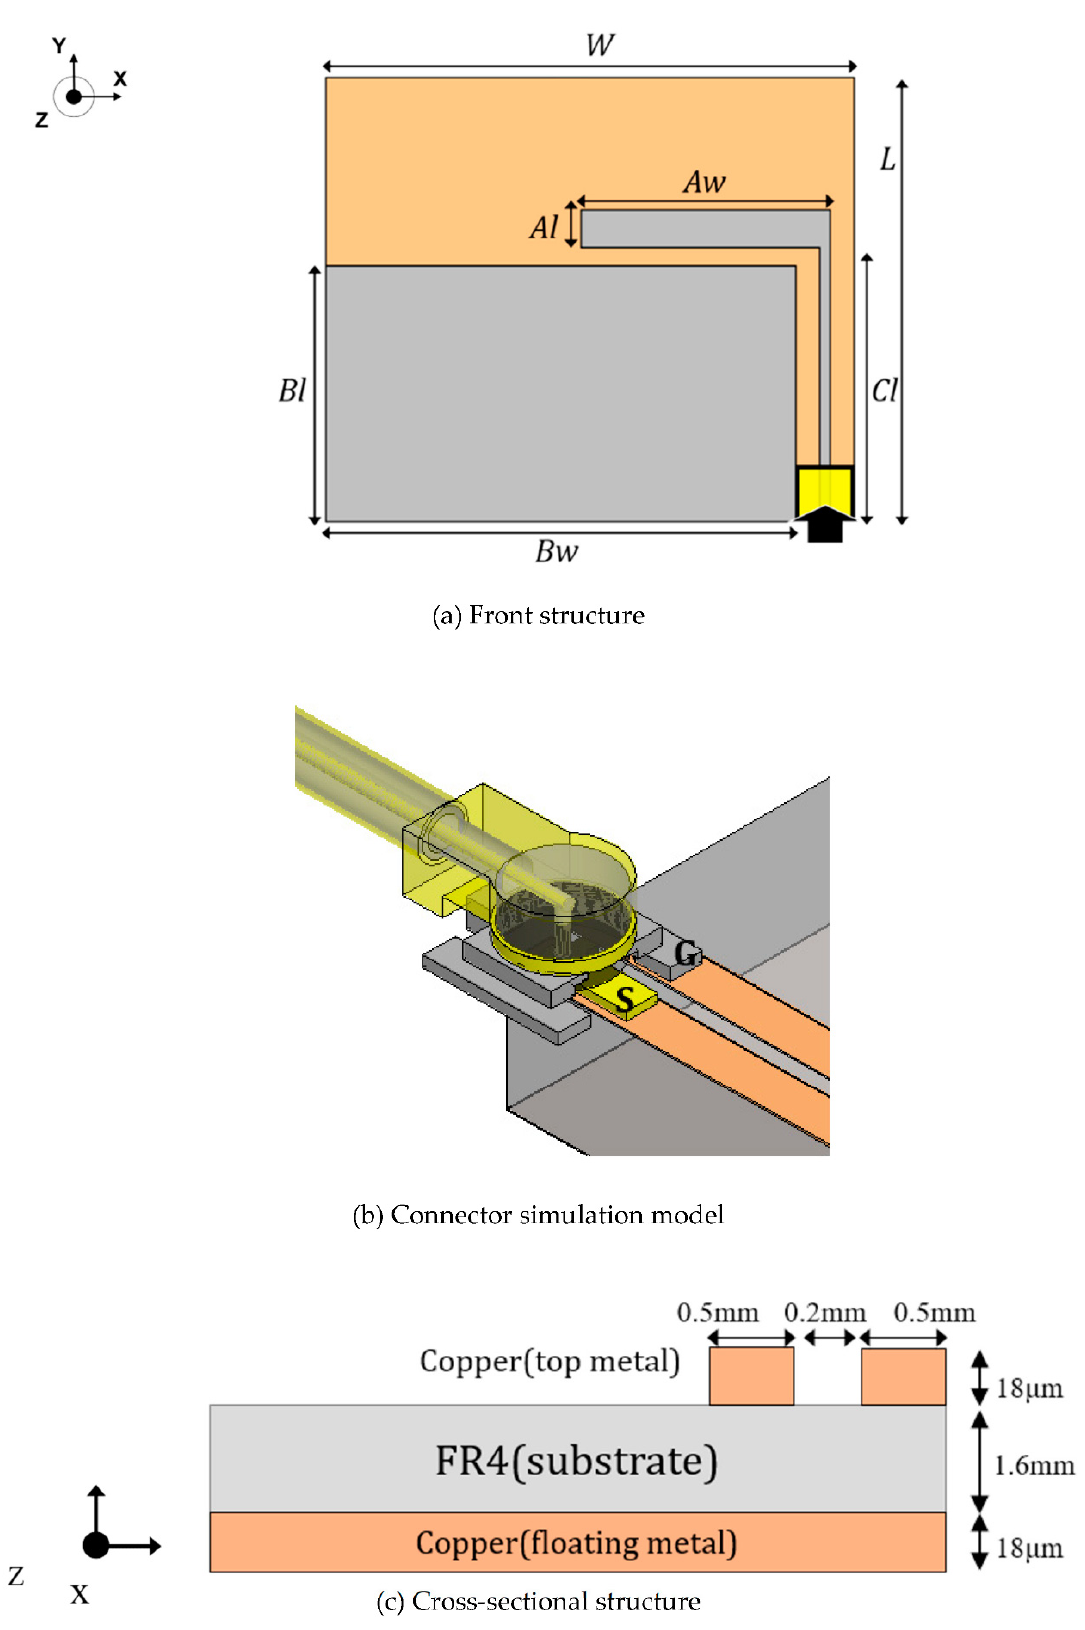
Figure 1. Antenna element structure: ( a ) front structure of the antenna element, ( b ) simulation model of the connector, and ( c ) cross-sectional structure of the antenna element.